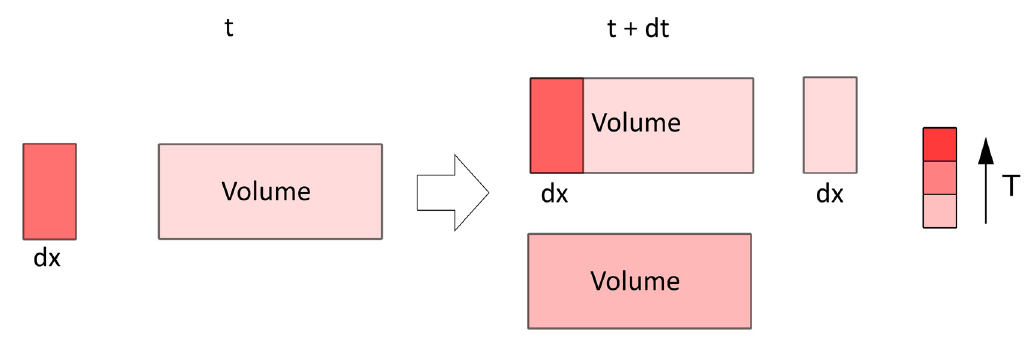
Figure 10. Mixing process model schematic.